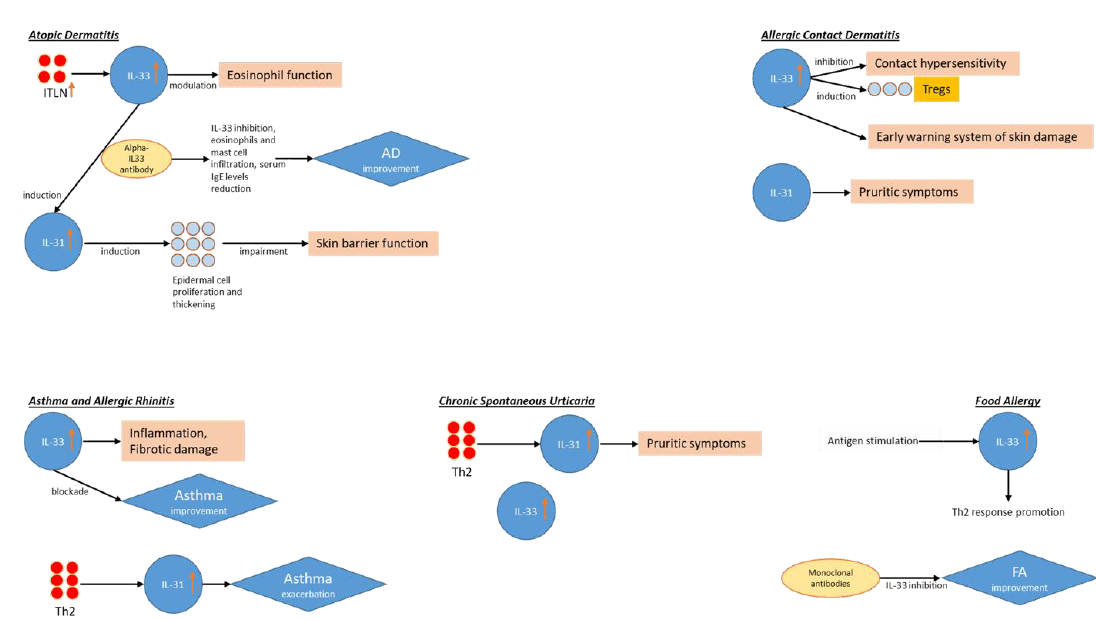
Figure 2. IL-31 and IL-33 involvement in allergic disorders: atopic dermatitis (AD), allergic contact dermatitis (ACD), asthma and allergic rhinitis, chronic spontaneous urticarial (CSU), and food allergy